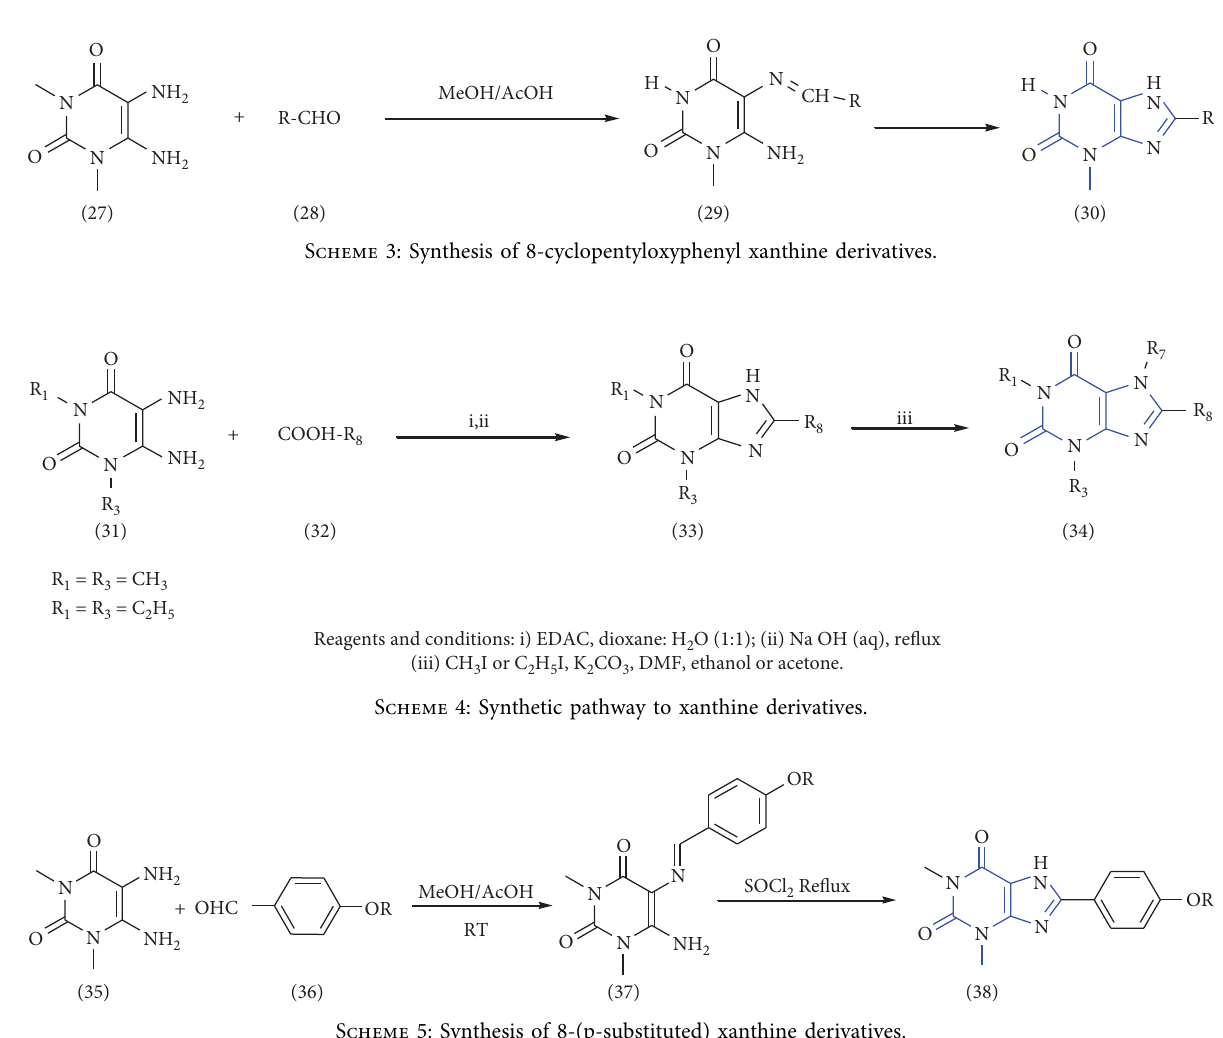
Scheme 2: Synthesis of 1-,3-,8-trisubstituted 1H-purine-2,6(3H,9H)-diones.